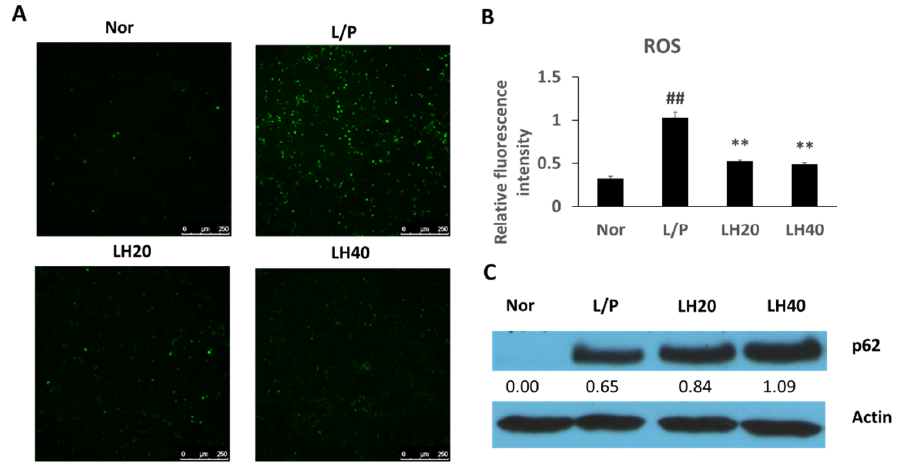
Figure 8. ( A,B ) Effects of LH on reactive oxygen species (ROS) and ( C ) p62 levels in THP-1 cells. Nor, normal control; L/P, LPS- and PMA-induced control group. LH20 and LH40: LPS- and PMA-induced groups simultaneously treated with LH (high pure mogroside V) at final concentrations of 20 and 40 µg/mL, respectively. Data are presented as mean ±SD, ## P < 0.01 vs. normal control group; ** P <0.01 vs LPS- and PMA-induced control group (n = 3).